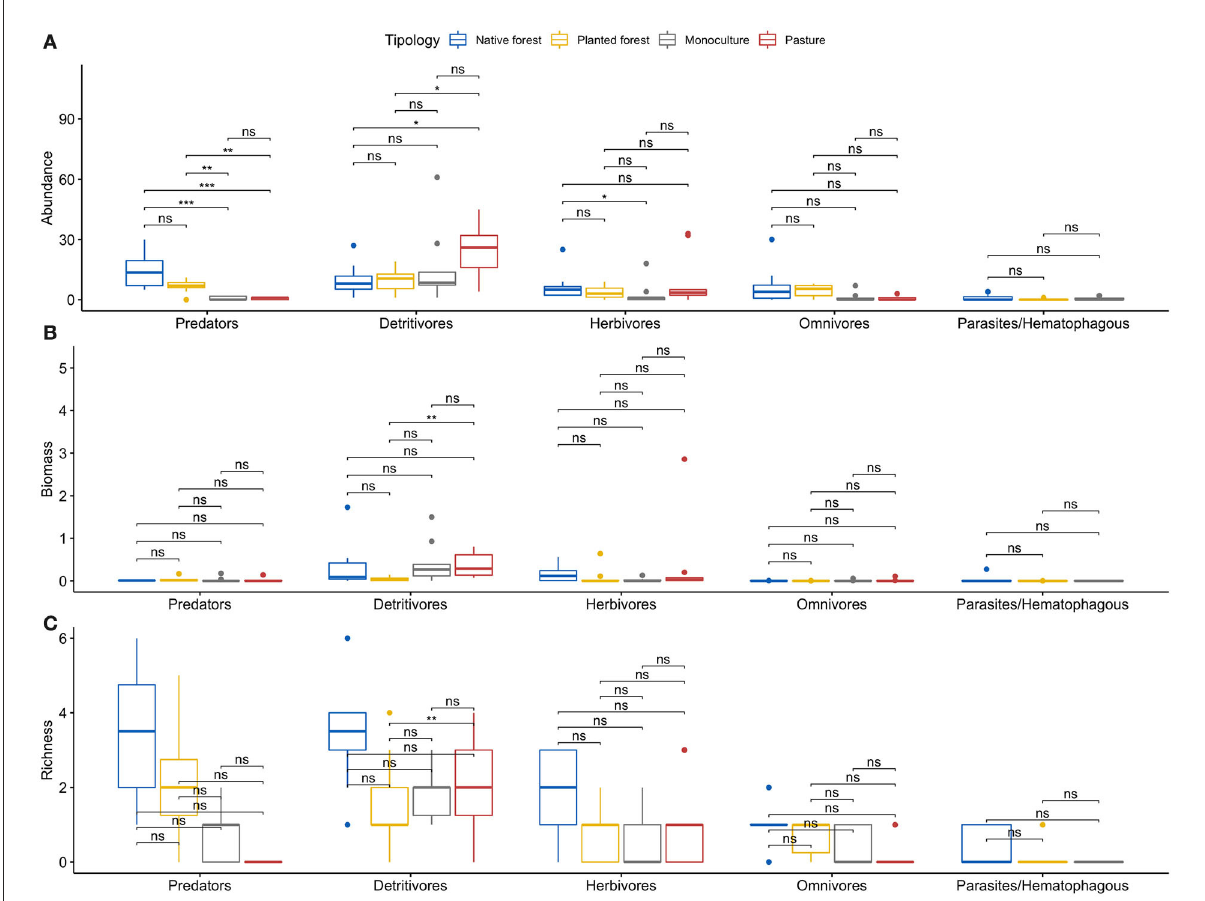
FIGURE5 Multiple boxplots for (A) abundance, (B) biomass, and (C) richness for trophic groups of soil macroinvertebrates by land use category. Asterisks illustrate the power of the levels of significance of the statistical tests: * p ≤ 0.05; ** p ≤ 0.01; *** p ≤ 0.001 and ns represents p > 0.05.